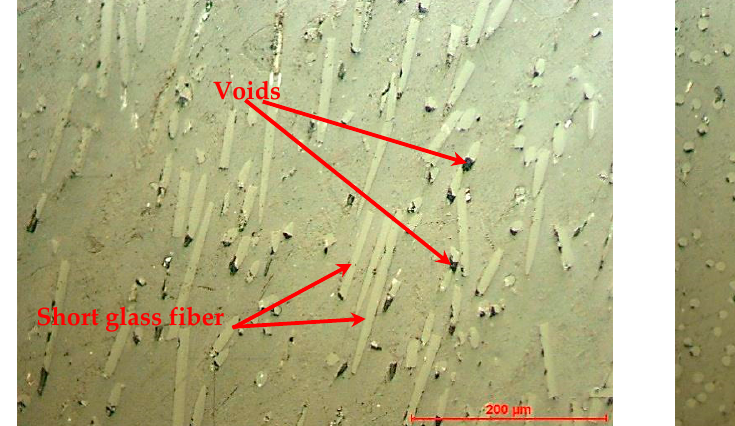
( b ) cross-section (100×).